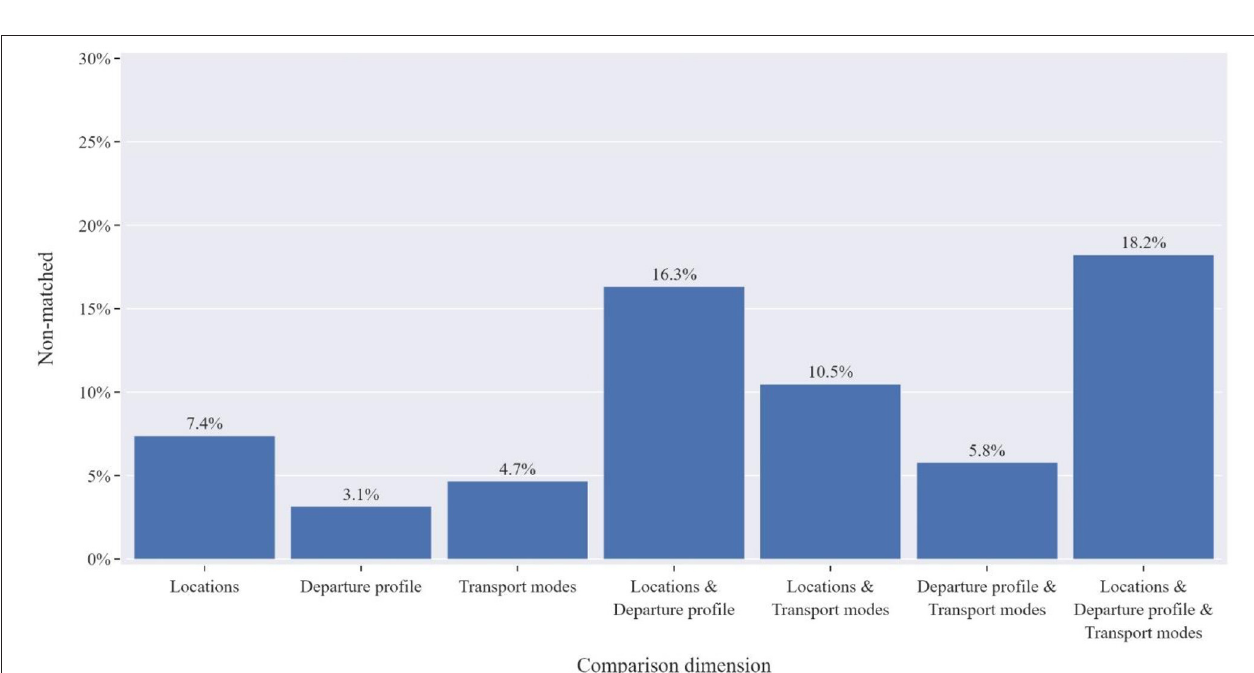
FIGURE 8 | Scatter plot comparing the observed and the modeled origin–destination (OD) matrices.